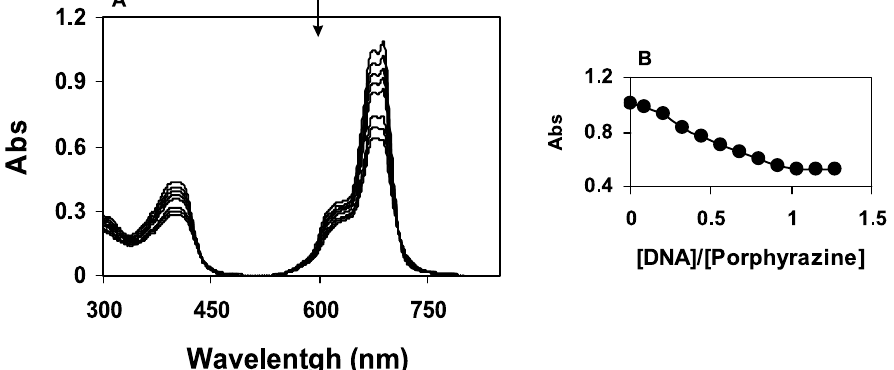
Fig. 3. (A): Absorption spectra of Zn (tmtppa) (15 . 4 (cid:1) M) in the presence of DNA: 0, 1.82, 3.60, 5.35, 7.07, 10.40, 12.00 and 13 . 60 (cid:1) M. The arrow indicates the absorbance changes with increasing [ct-DNA]. (B) The variation of absorbance at the Q-band (688 nm) versus mole ratio of DNA to Zn